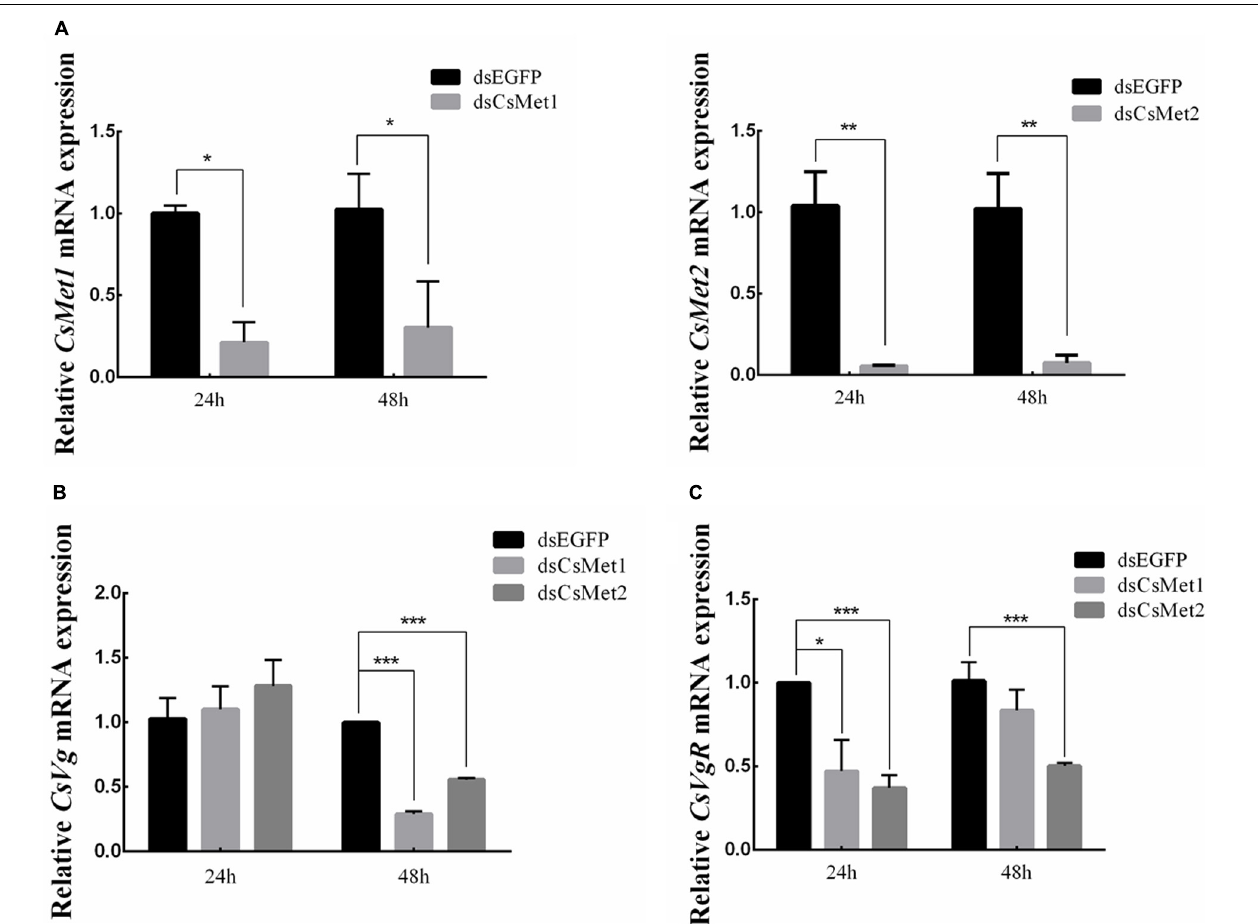
FIGURE 5 | Knockdown of CsMet1 and CsMet2 . dsRNAs were injected into 6-day-old female pupae followed by the second injection into the newly emerged female moths. The expression levels of CsMet1 , CsMet2 (A) , CsVg (B) , and CsVgR (C) in whole body insects were examined at 24 h and 48 h after treatment. The bars represent mean ± SE of three biological replicates. Asterisks indicate the significant differences between the groups (* P < 0.05, ** P < 0.01, and *** P < 0.001).